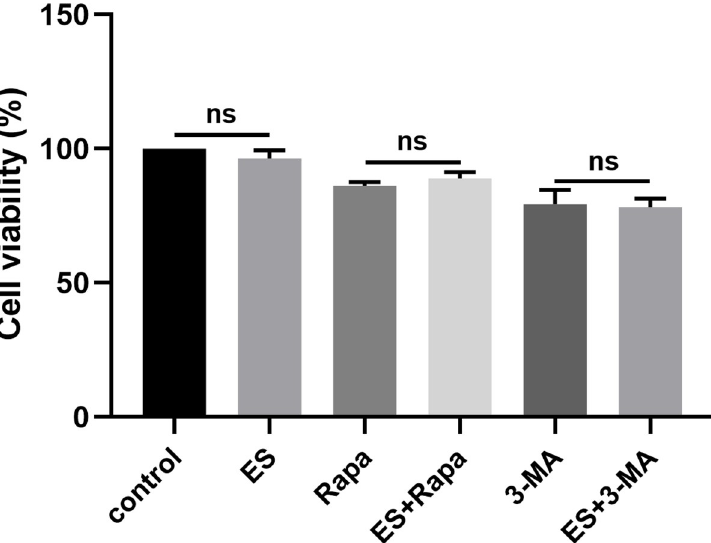
Fig 9. No significant effect of ES-suppressed autophagy on myoblasts viability. Cell viability was detected using the CCK8 assay following that C2C12 myoblasts were treated with or without 1 μ g/ml ES, rapamycin (100 nM), and 3-MA (5 mM) for 3 h. The data represent at least 3 independent experiments and are expressed as mean ± SD. ns = no significance.